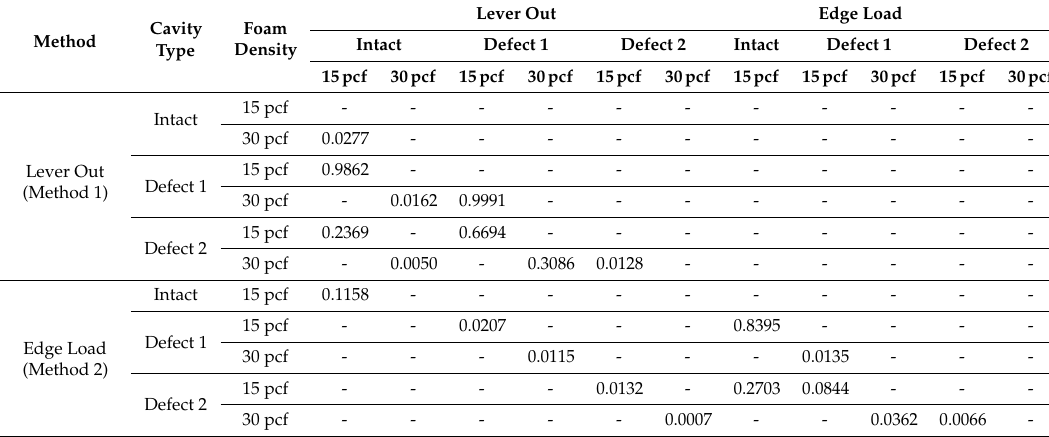
Table 3. Tabular listing of the p -values (Welch’s ANOVA with Games–Howell post-hoc test) determined for the parameter Interface stiffness k for the various combinations of foam density, cavity type, and test method. The values of p < 0.05 were defined as significant. The group of the intact cavity and 30 pcf foam density for Method 2 was excluded, because the group consisted of only one value.